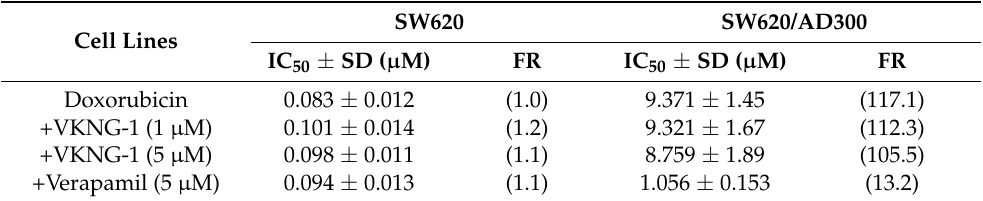
Table 3. The reversal effect of VKNG-1 on the cytotoxicity of anticancer drugs in ABCB1- overex- pressing cells.